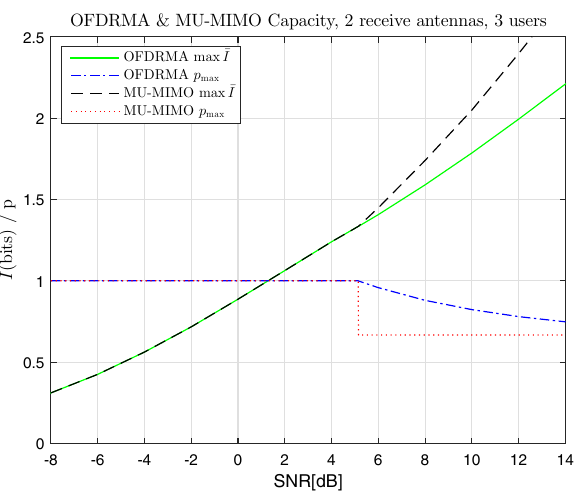
Figure 2. OFDRMA & MU-MIMO comparison of capacity and corresponding p values vs SNR, ϑ = 2 , u = 3 .